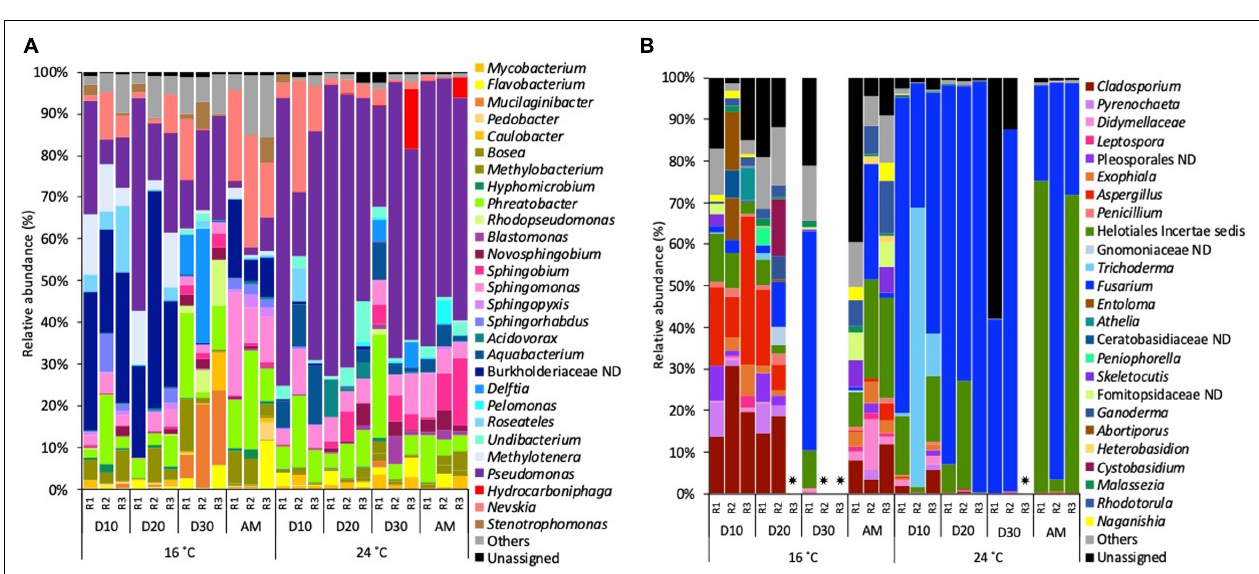
FIGURE 4 | Relative abundance of (A) bacterial genera and (B) fungal genera ( > 1% of the total sequences) at 16 and 24 ◦ C in bulk water samples every 10 days (D) throughout the growth phase and after the mobilisation phase (AM). The 3 replicates (R1, R2, and R3) per sampling point are represented. Remaining genera were combined in category “Others.” Category “Unassigned” correspond to unidentified OTUs and “ND” means not defined at that level. ✷ Samples that did not amplify during the sequencing process.